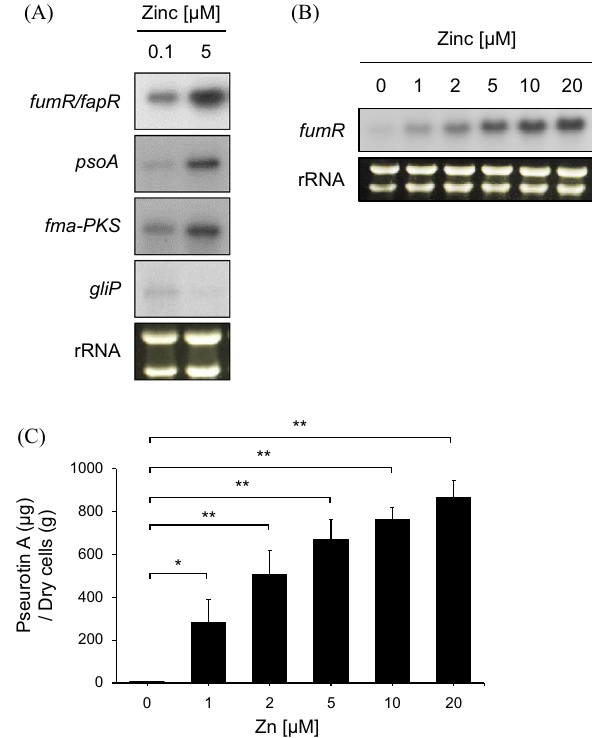
Figure 2. The genes involved in pseurotin A biosynthesis were regulated by zinc. ( A ) The genes shown in the microarray data were confirmed by northern blotting. The cells were cultured in Czapek-Dox media with the indicated zinc concentration, and total RNA was extracted to perform northern blotting. The loading control was the rRNA. ( B ) The zinc dependence of the expression of fumR was investigated. The cells were cultured in Czapek-Dox media with the indicated zinc concentration, total RNA was extracted, and northern blotting was performed. Pseurotin A was extracted and measured from the same culture media ( C ). * p < 0.05 and ** p < 0.01 indicate a significant difference compared to the control